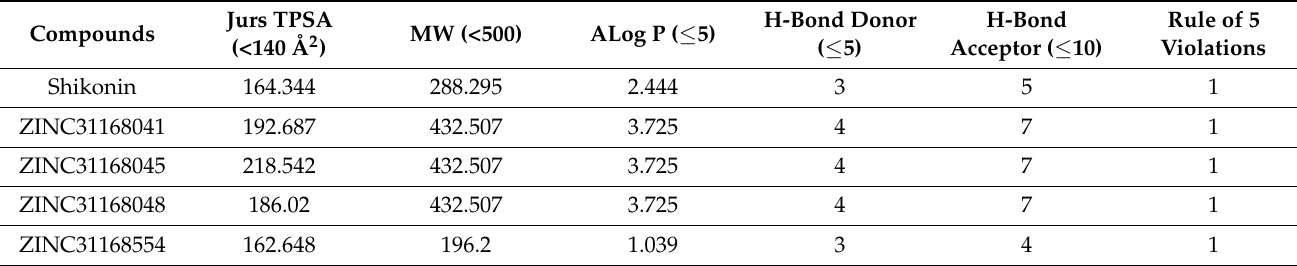
Table 2. Computed drug-likeness for Shikonin and filtered compounds by the Lipinski and Veberrule. Compounds